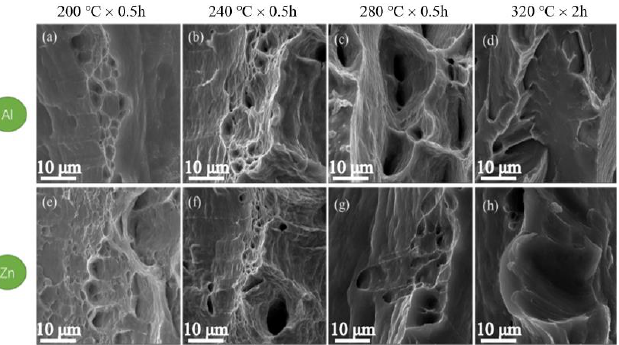
Figure 14. Macroscale images of the fractures.